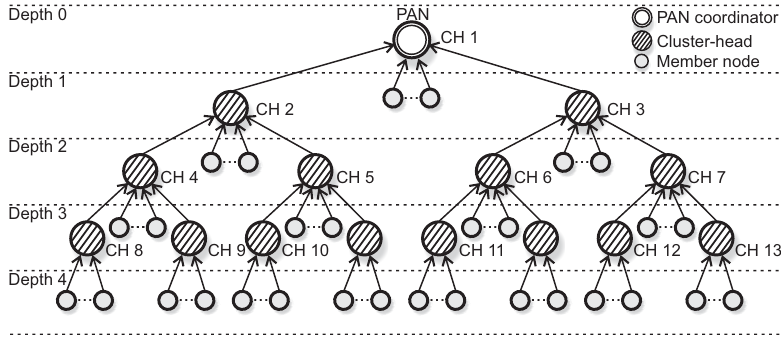
Figure 2. IEEE 802.15.4/ZigBee cluster-tree